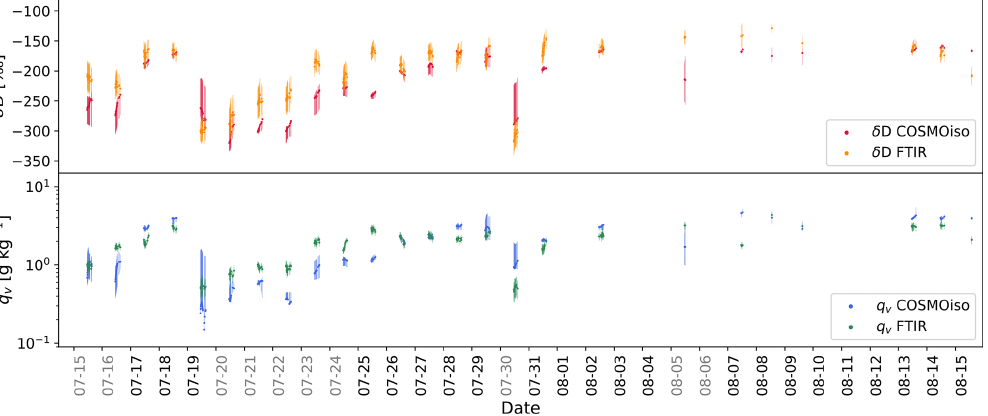
Figure 6. Time series of COSMO iso and ground-based FTIR remote sensing q v and δ D obtained for the 4.9km retrieval level (representative of 3–7km) above Tenerife around midday. The shadings represent the estimated COSMO iso uncertainties (based on the minimum and maximum δ D and q v values of the eight neighbouring grid points) and the FTIR random errors. Grey dates on the x axis indicate days with a less reliable air parcel transport (see Sect. 2.4).